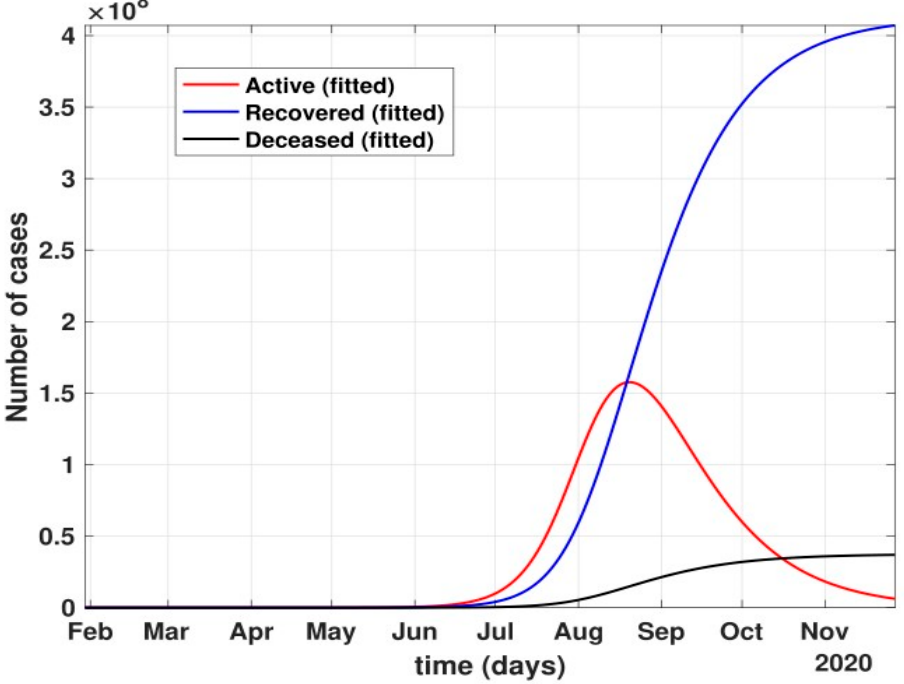
Figure 10. Prediction of the number of active cases after strict lockdown ended and a phased re-opening of the country was in place, i.e., after 4 May